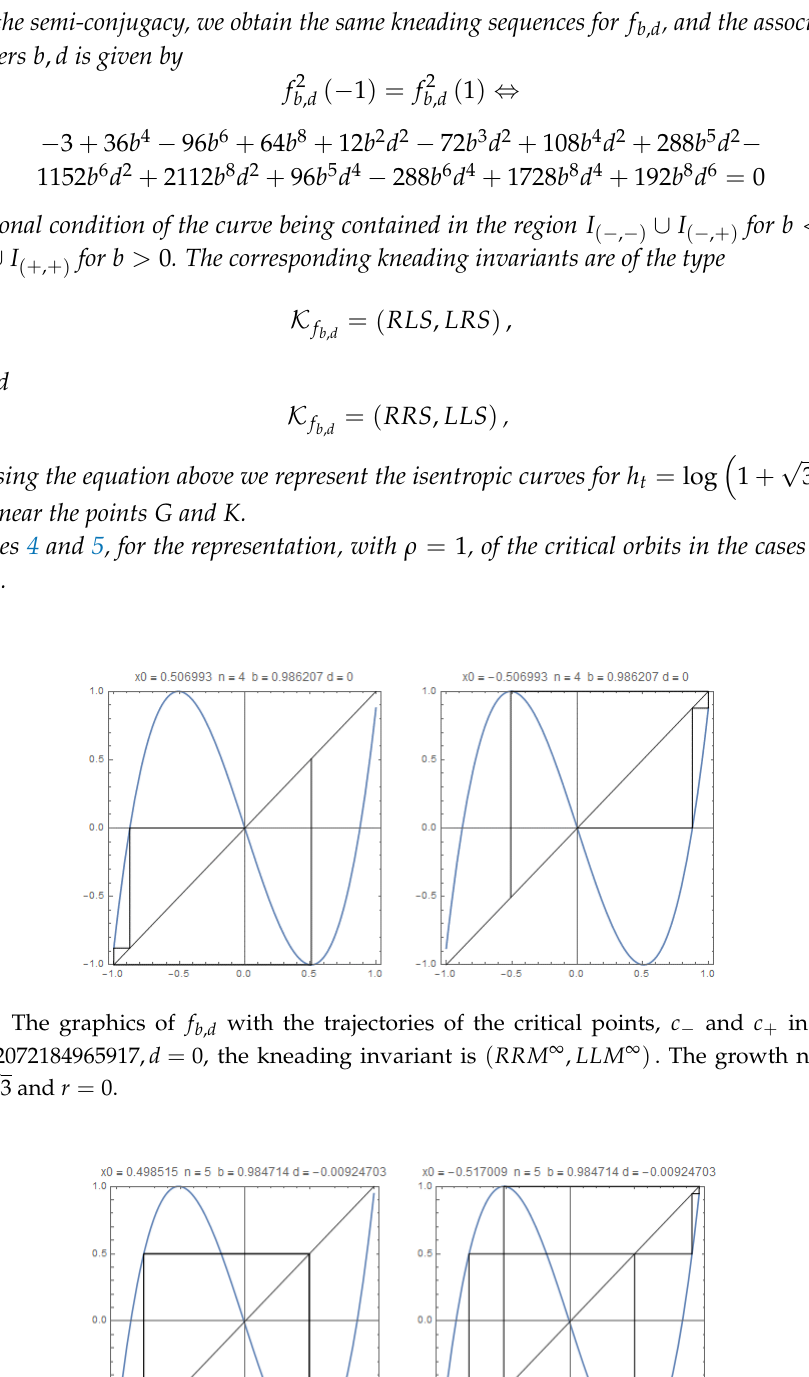
∞ ∞ (cid:1) (cid:0) RR ( C + LL ) , LL ( C + LL ) .